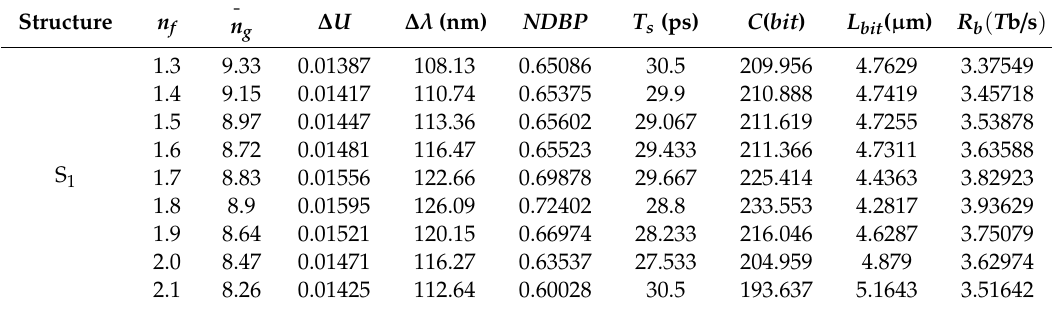
Figure 5. Slow-light properties of the optimum S1 SP-CS-SPCW for refractive indices of RTILs ( n ) varying from 1.3 to 2.1 at l = 1.25 a versus normalized frequency a/ λ for ( a ) group index ( n g ) and ( b ) group-velocity dispersion ( GVD ) .